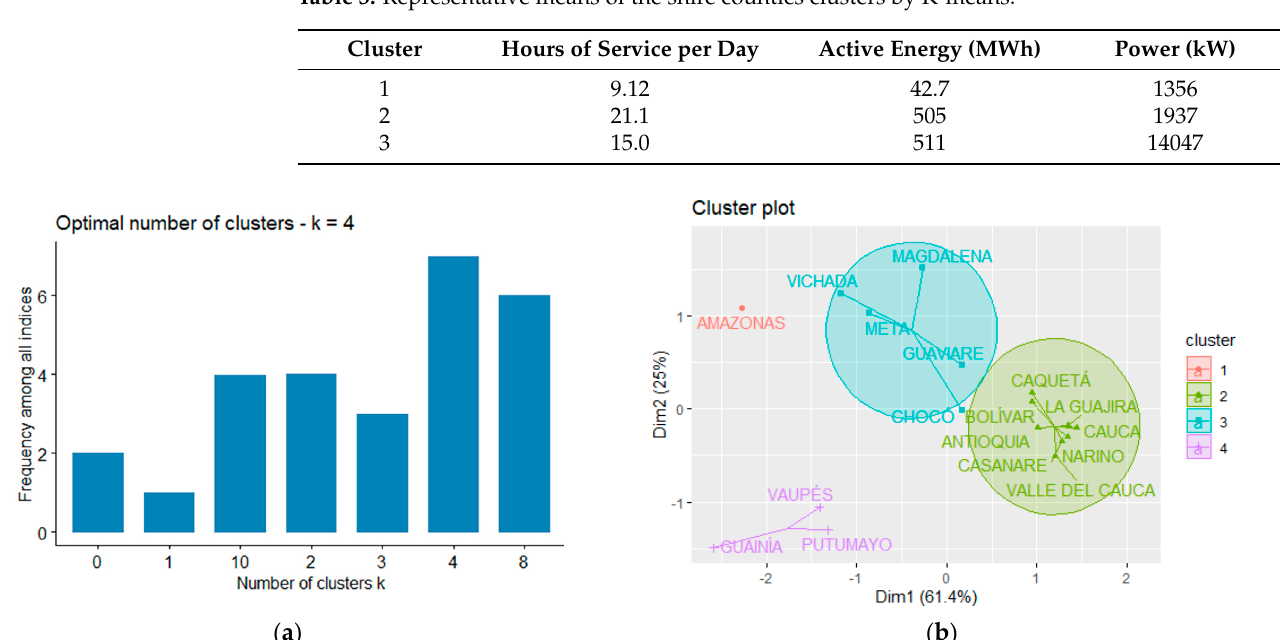
Figure 3. ( a ) Optimal number of clusters; ( b ) clusters by K-means algorithm (shire counties, active energy, operating hours, and power). Table 3. Representative means of the shire counties clusters by K-means.